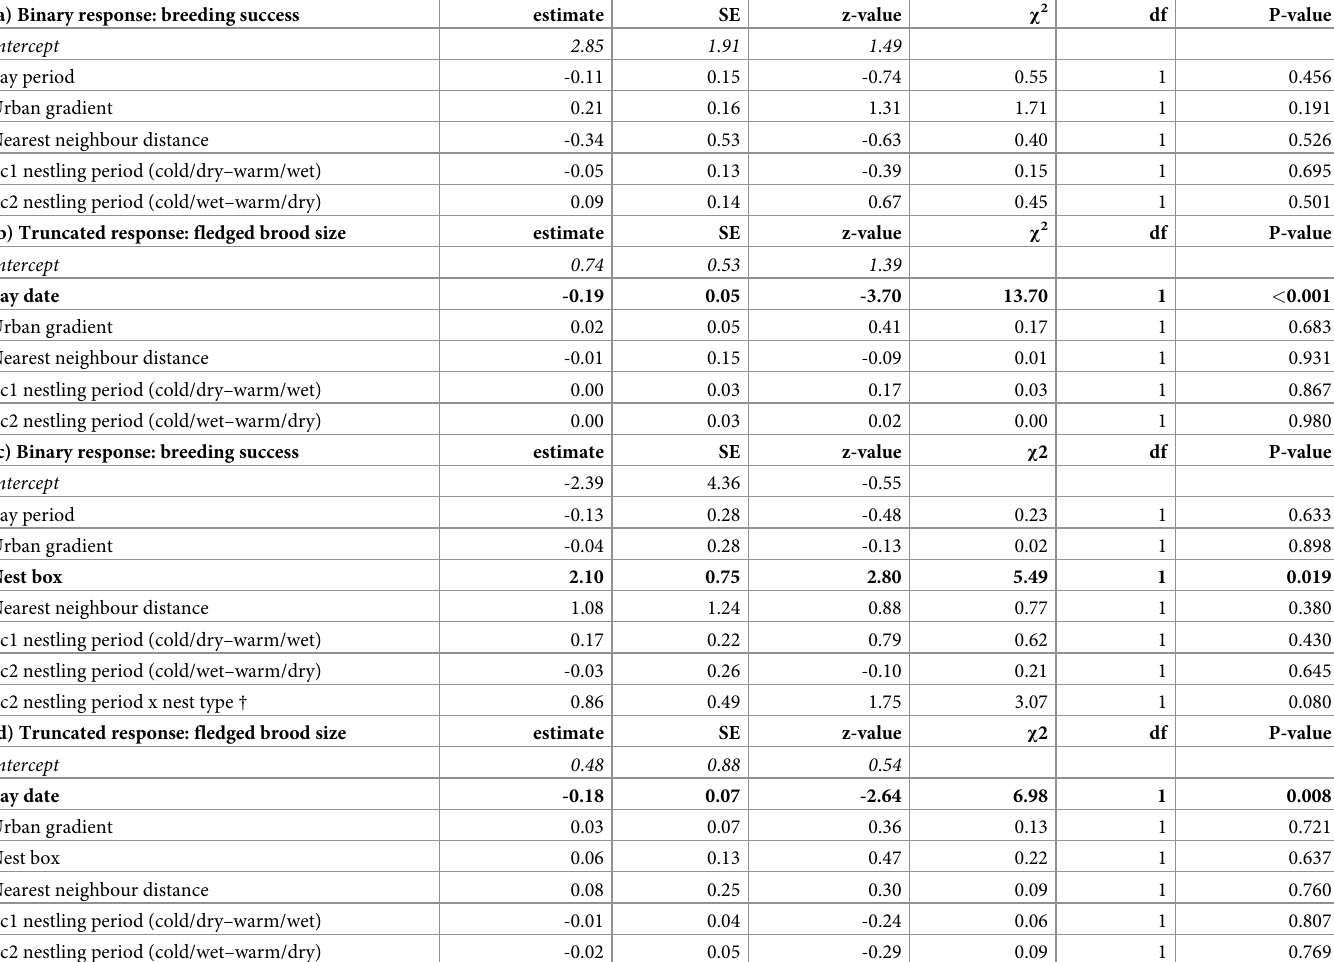
Table 4. Hurdle model for breeding productivity (a) binary part: breeding success (n = 399); (b) truncated part: fledged brood size (n = 316 broods with a successful breeding outcome, 52 territories over 26 years); and, (c/d) n = 159/188 broods on the urban subset (including only nests with > 40% urban